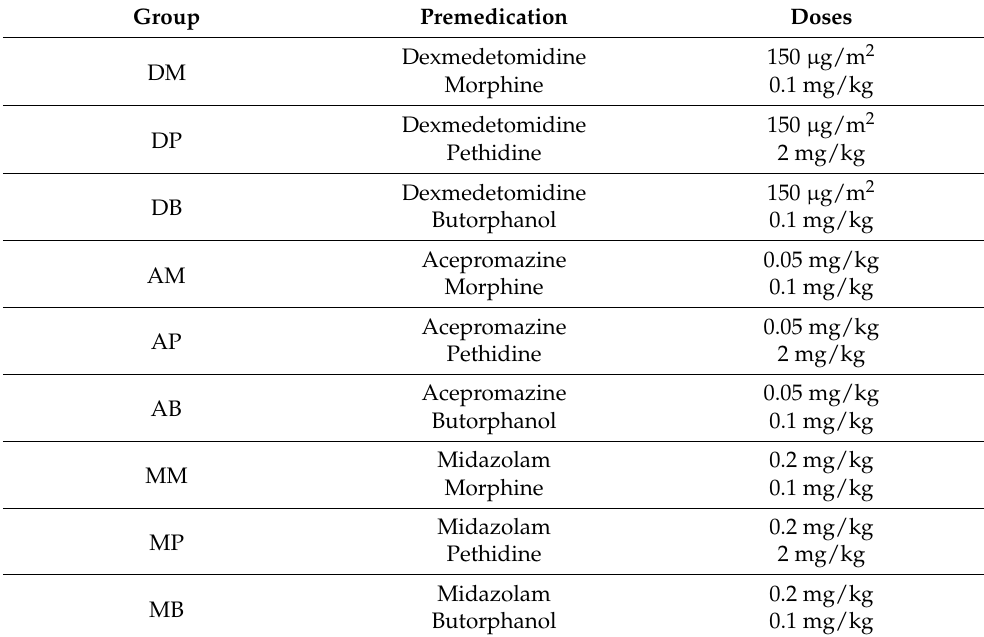
Table 1. Premedication drugs and the doses administered in each of 9 experimental group of dogs submitted to esophageal pH measurement during anesthesia for non-intrabdominal, non- intrathoracic